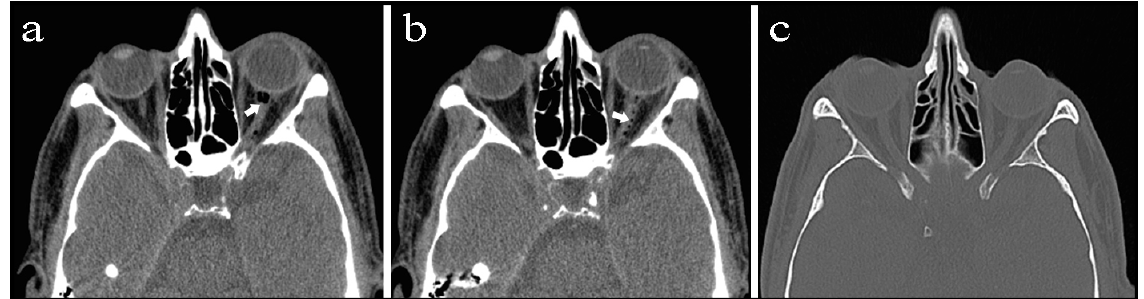
Figure 1: Computerized tomography (CT) images of the optic nerve sheath penetration (a) Air bubbles within the left (operated) optic nerve indicate optic nerve sheath penetration (arrow). (b) Movements of air bubbles to the chiasm (arrow). (c) The follow-up CT scan at day 3 shows disappeared air bubbles in the left optic nerve